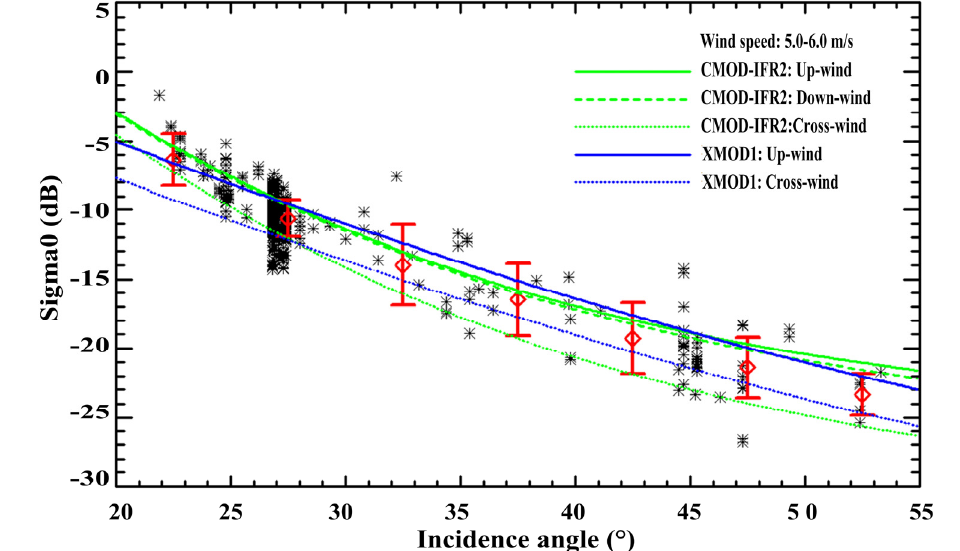
Figure 5. Comparison among the NRCSs of CMOD-IFR2, XMOD1 and